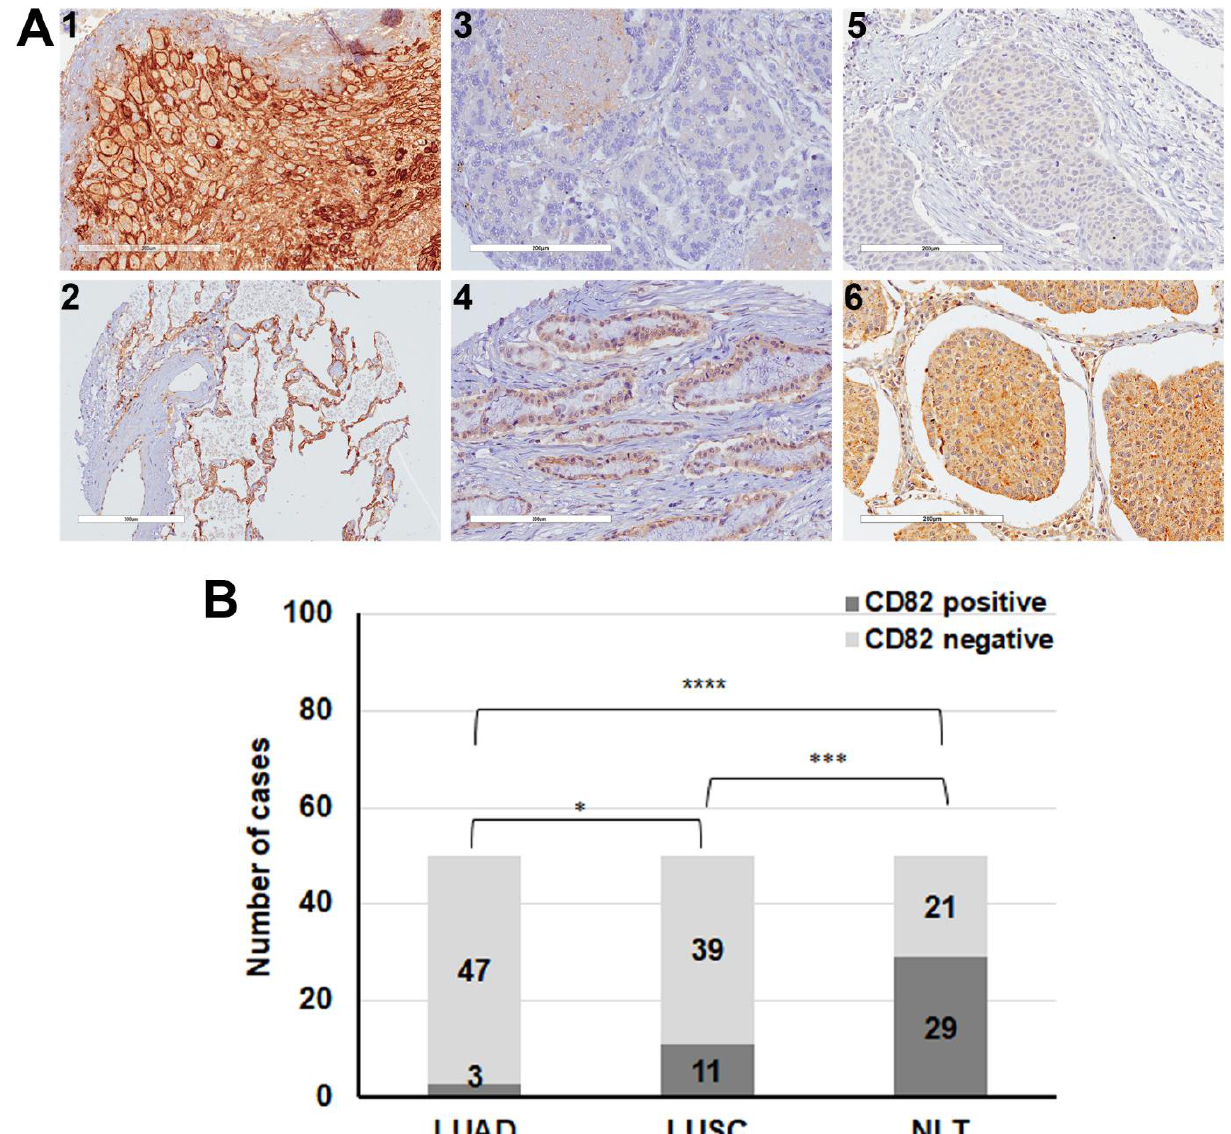
Figure 4. Expression CD82/KAI1 expression in normal and tumour human lung tissue samples. ( A ) Analysis of CD82 expression in normal human lung tissue (NLT) ( n = 50) and patient-derived human LUAD ( n = 50) and LUSC ( n = 50) tissue microarrays (TMAs) by immunohistochemistry. 1 Placenta tissue sample used as a positive control for CD82 expression. 2 Normal human lung tissue showing expression of CD82 localised in the plasma membrane of lung epithelial cells, 3 LUAD negatively stained for CD82. 4 LUAD exhibiting cytoplasmic staining of CD82 in the tumour cells. 5 , 6 , LUSC negatively and positively stained for CD82, respectively. (Scale 1, 3, 4, 5, 6, 200 μ m, and 2, 300 μ m). ( B ) Statistical analysis of CD82 expression in TMAs of normal human lung tissue and in lung tissues of patients with LUAD and LUSC by Fisher’s exact test (* p < 0.05, *** p < 0.001, **** p < 0.0001).